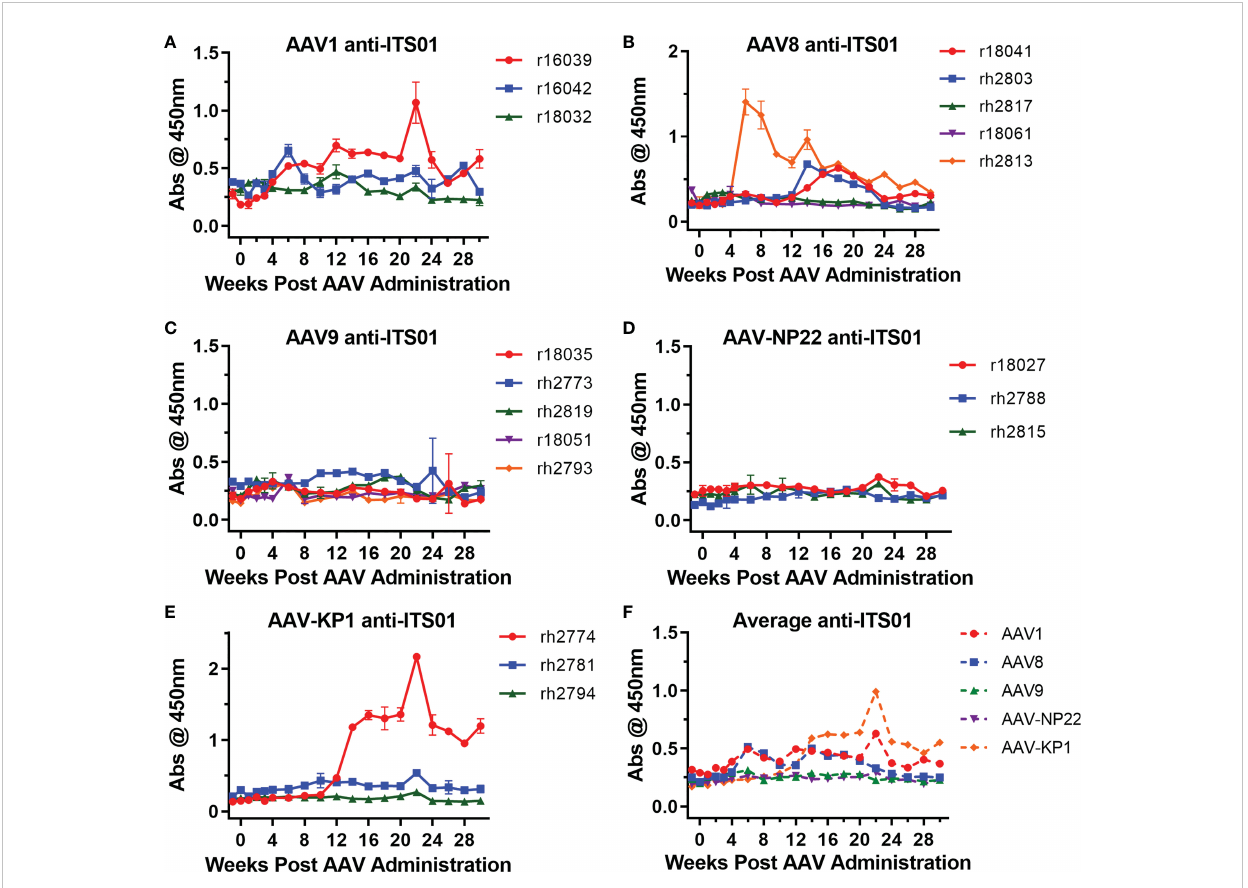
FIGURE 5 Low ADA responses against expressed ITS01 in all groups. ADA responses were measured by ELISA. ITS01-coated plates were incubated with diluted serum samples from the incubated timepoints. Anti-ITS01 antibodies were detected using a human, anti-lambda secondary. (A – E) The absorbance values for each macaque from the study are graphed based on capsid group. Error bars indicate S.D. (F) Average absorbance values for the fi ve groups. Overall, 13 of 19 macaques have ADA responses around the absorbance values of the pre-administration time